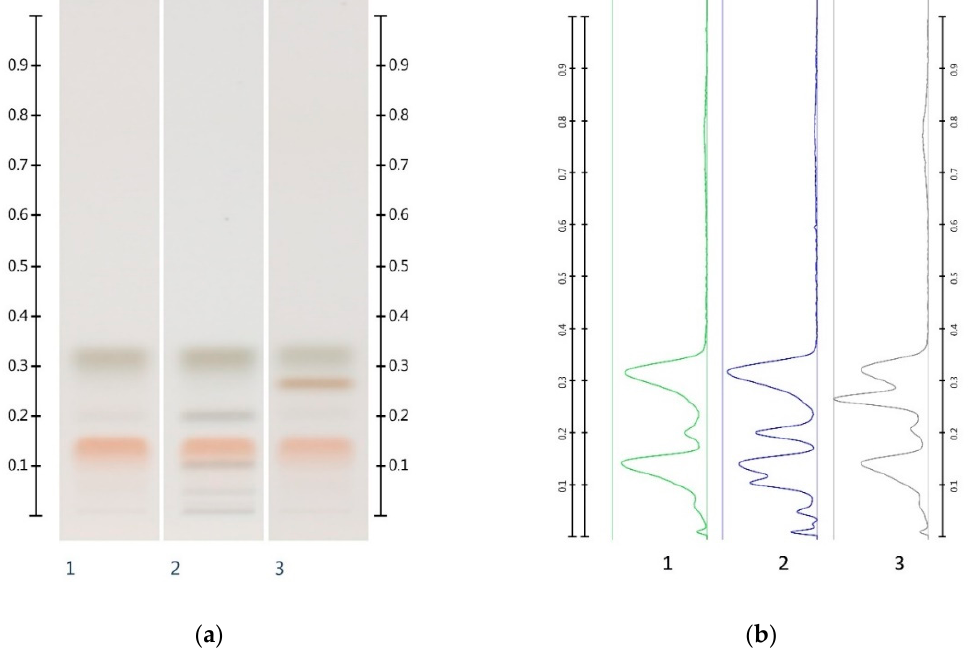
Figure 4. Images taken at T White light; ( a ) Track 1—MAN, Track 2—MAN-GLU 30%, Track 3—MAN-MAP 30%; ( b ) their respective chromatograms.